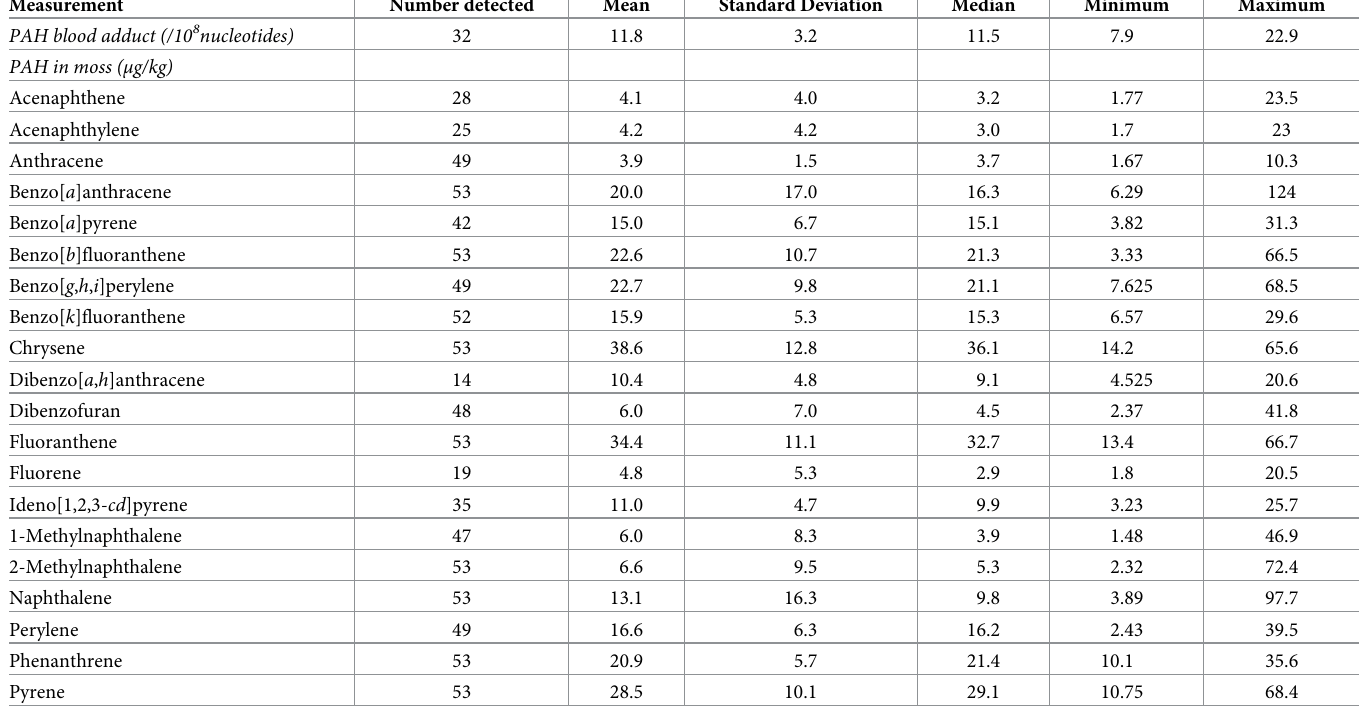
Table 1. Descriptive statistics of measurements the levels of polycyclic aromatic hydrocarbons (PAH) in moss and blood among measurements above limit of detec- tion; 53 samples collected for each